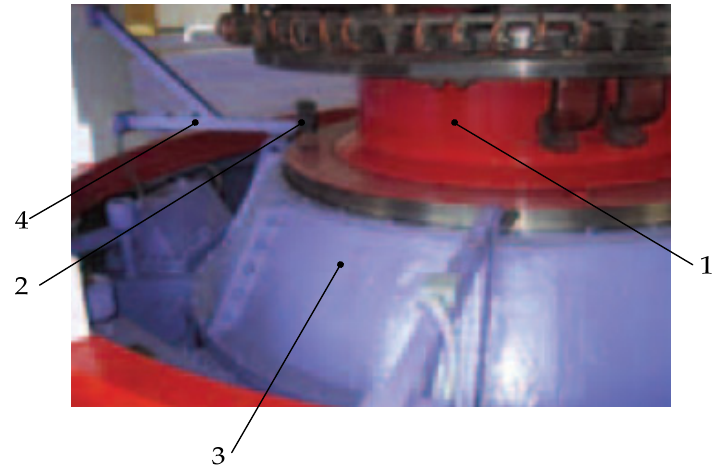
Figure 4. Installing absolute vibration sensors: 1—shaft, 2—sensor, 3—housing, 4—sensor mount.